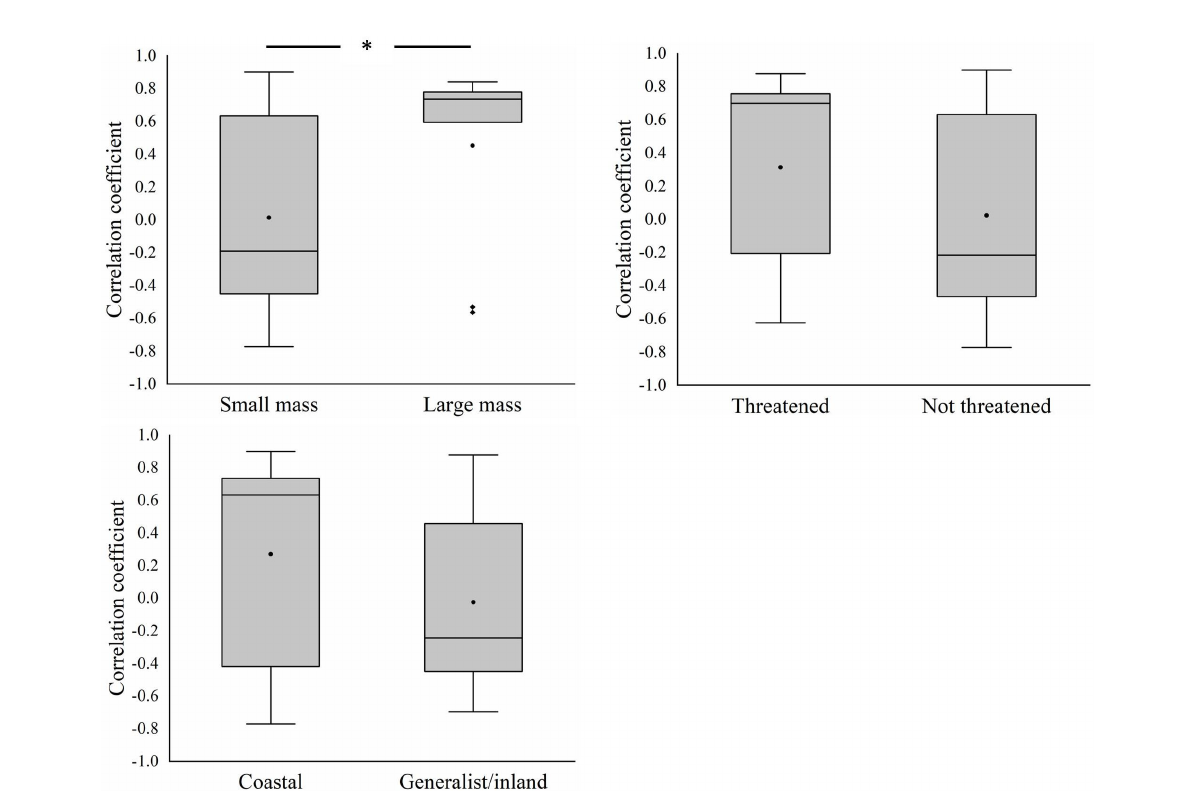
FIGURE 6 Differences in the correlation coef fi cients between mean patch area and the abundance of different groups of shorebird species in the Yellow River Delta. Black circles represent mean values, horizontal bars within boxes represent median values, the upper and lower limits of boxes represent the maxima and minima, respectively, and whiskers represent 1% and 99%. Black squares represent abnormal value. *means signi fi cant at the 0.05